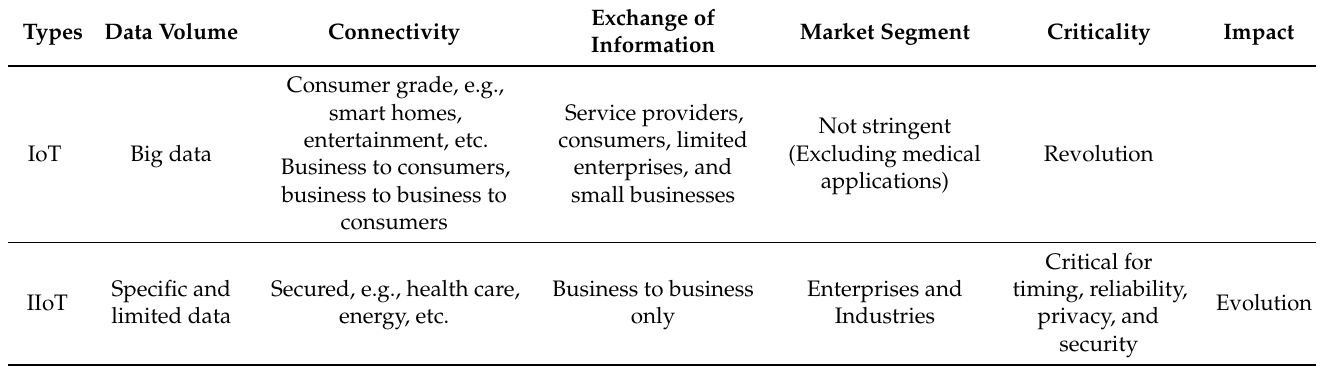
Table 2. Comparisons of IoT and IIoT